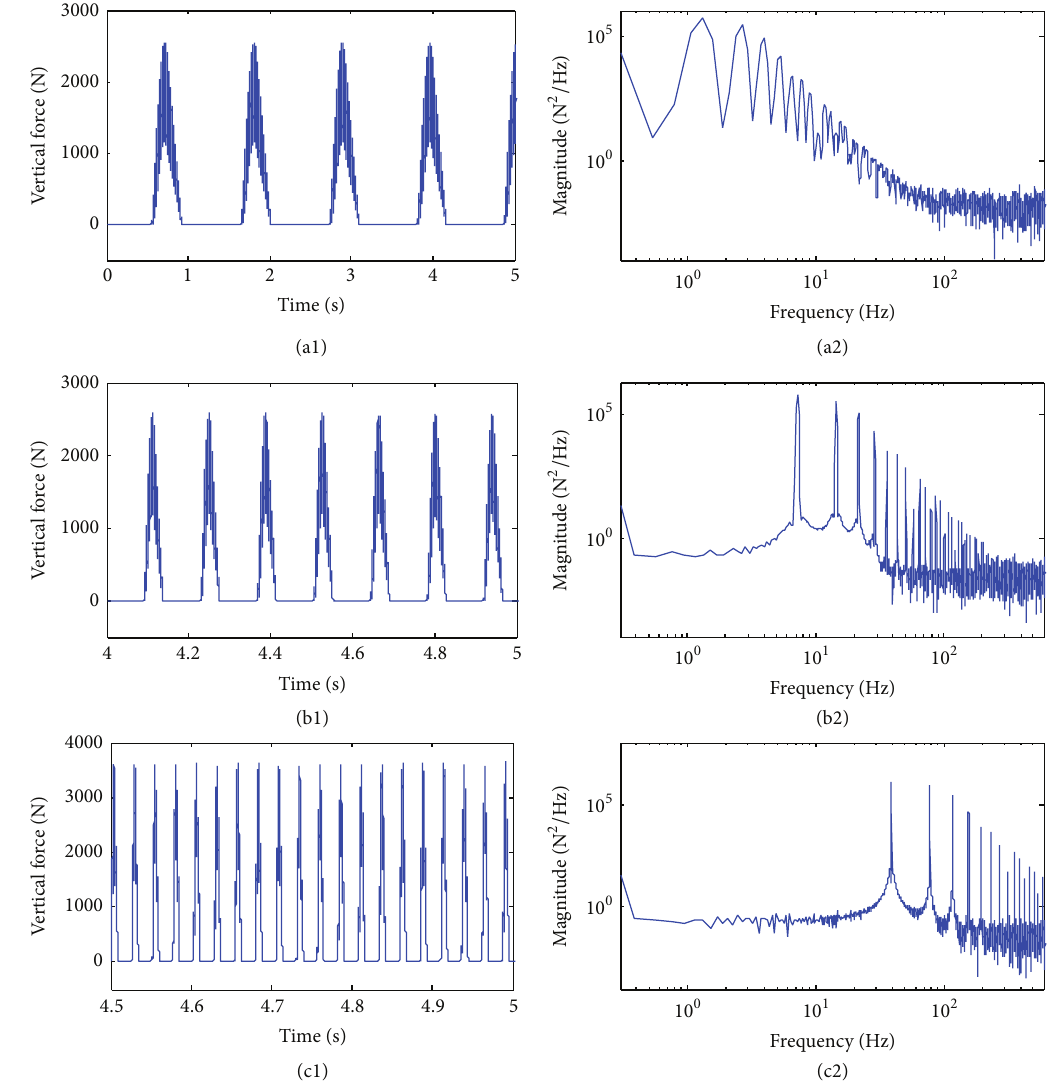
Figure 6: SRM vertical force. (a1) Time history of vertical force at vehicle 2 km/h. (a2) PSD of vertical force at vehicle 2 km/h. (b1) Time history of vertical force at vehicle 11km/h. (b2) PSD of vertical force at vehicle 11km/h. (c1) Time history of vertical force at vehicle 60 km/h. (c2) PSD of vertical force at vehicle 60